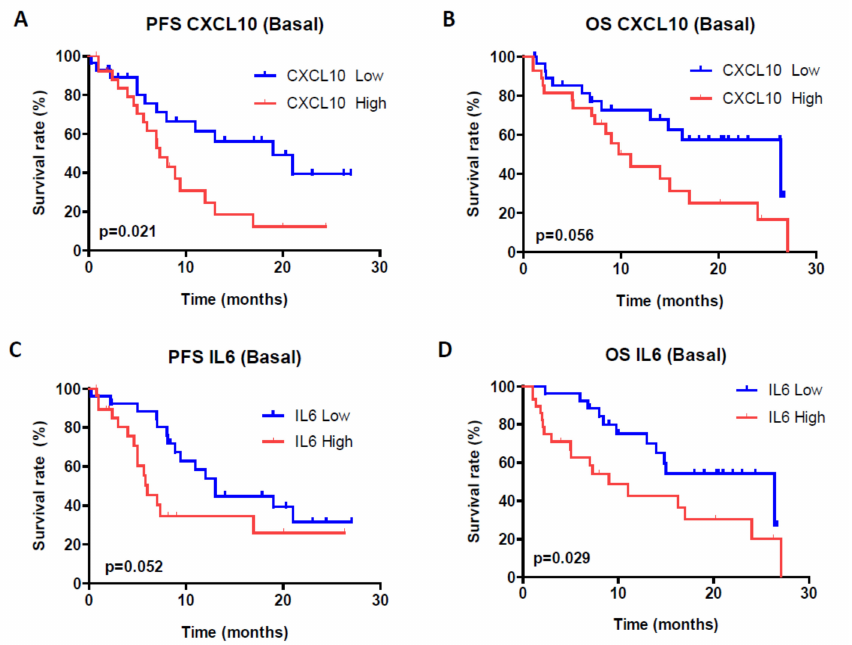
Figure 5. Blood levels of CXCL10 (IP-10) and IL-6. Both PFS ( A ) and OS ( B ) are significantly shorter in patients with high basal levels of CXCL10. Patients with high IL-6 basal concentration tend to show lower PFS ( p = 0.052) ( C ) and are statistically reduced in the case of OS ( p = 0.029) ( D